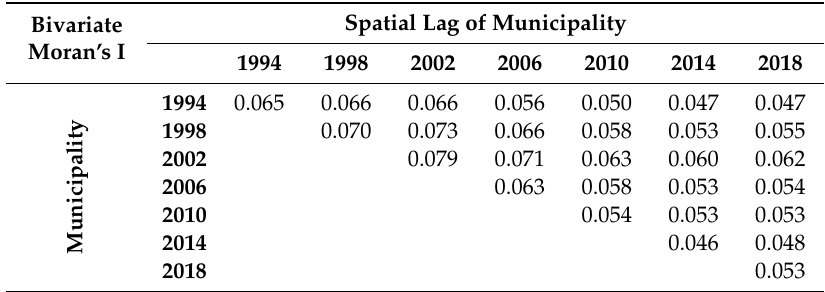
Bivariate Moran’s I statistic for women’s descriptive representation in Czech local elections,